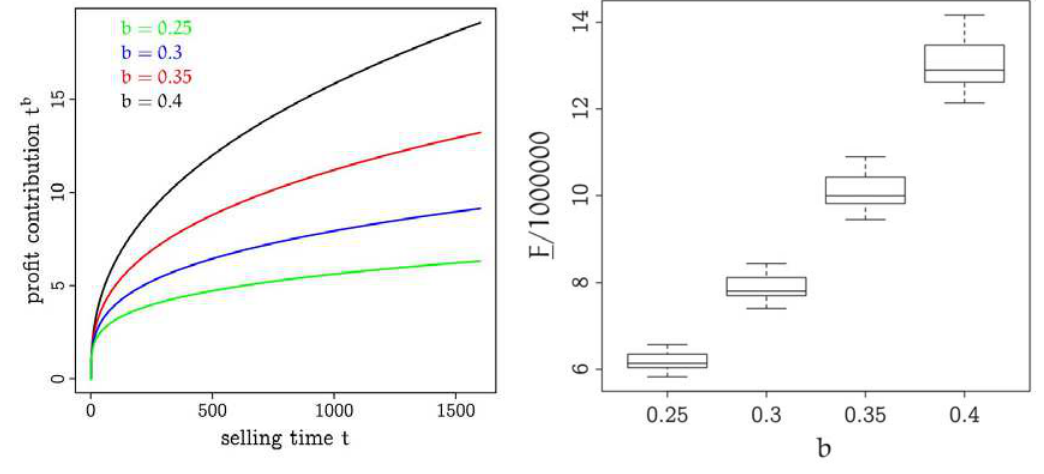
Fig. 1. Profit contribution, profit F , and elasticity b . Assuming c ij = 1 and o ij = 0 Figure (a) shows that the profit contribution remarkably varies in b . The same is true for the coherence of the objective function value F and elasticity b (Figure (b)). The box blots summarize results over 30 randomly generated instances. Source: Haase and Müller